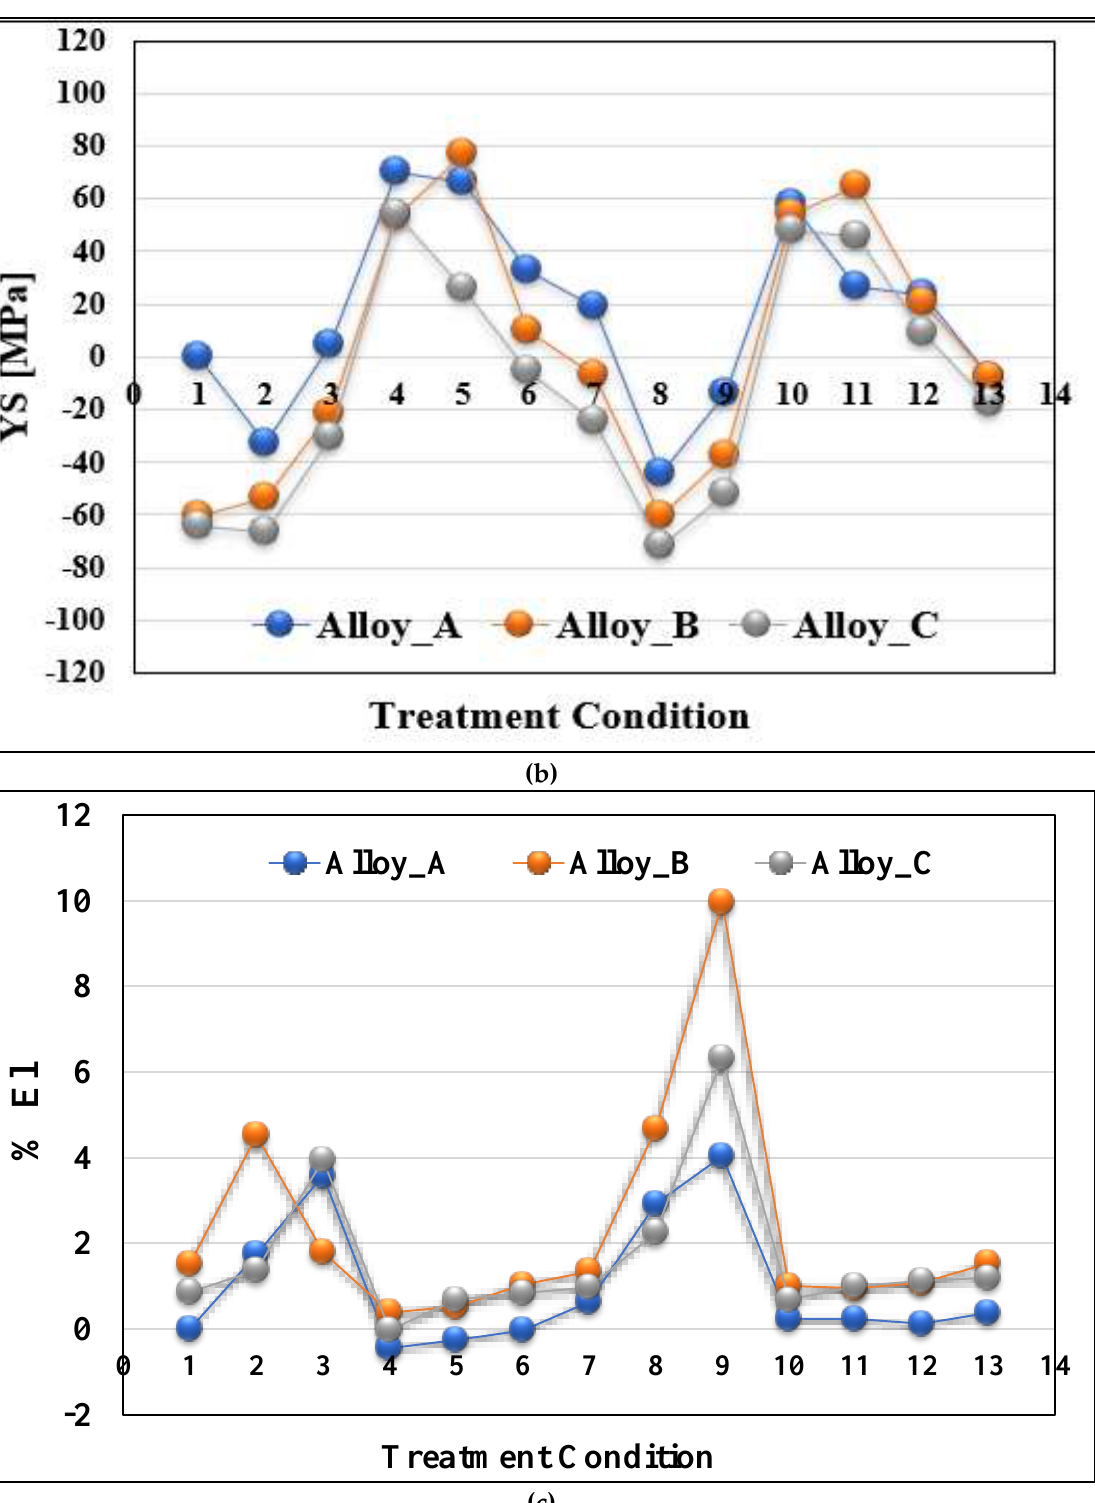
Figure 9. Contribution of the alloying elements and heat treatments to the tensile properties of alloy A in the as-cast condition: ( a ) UTS; ( b ) YS; ( c ) % elongation to fracture.